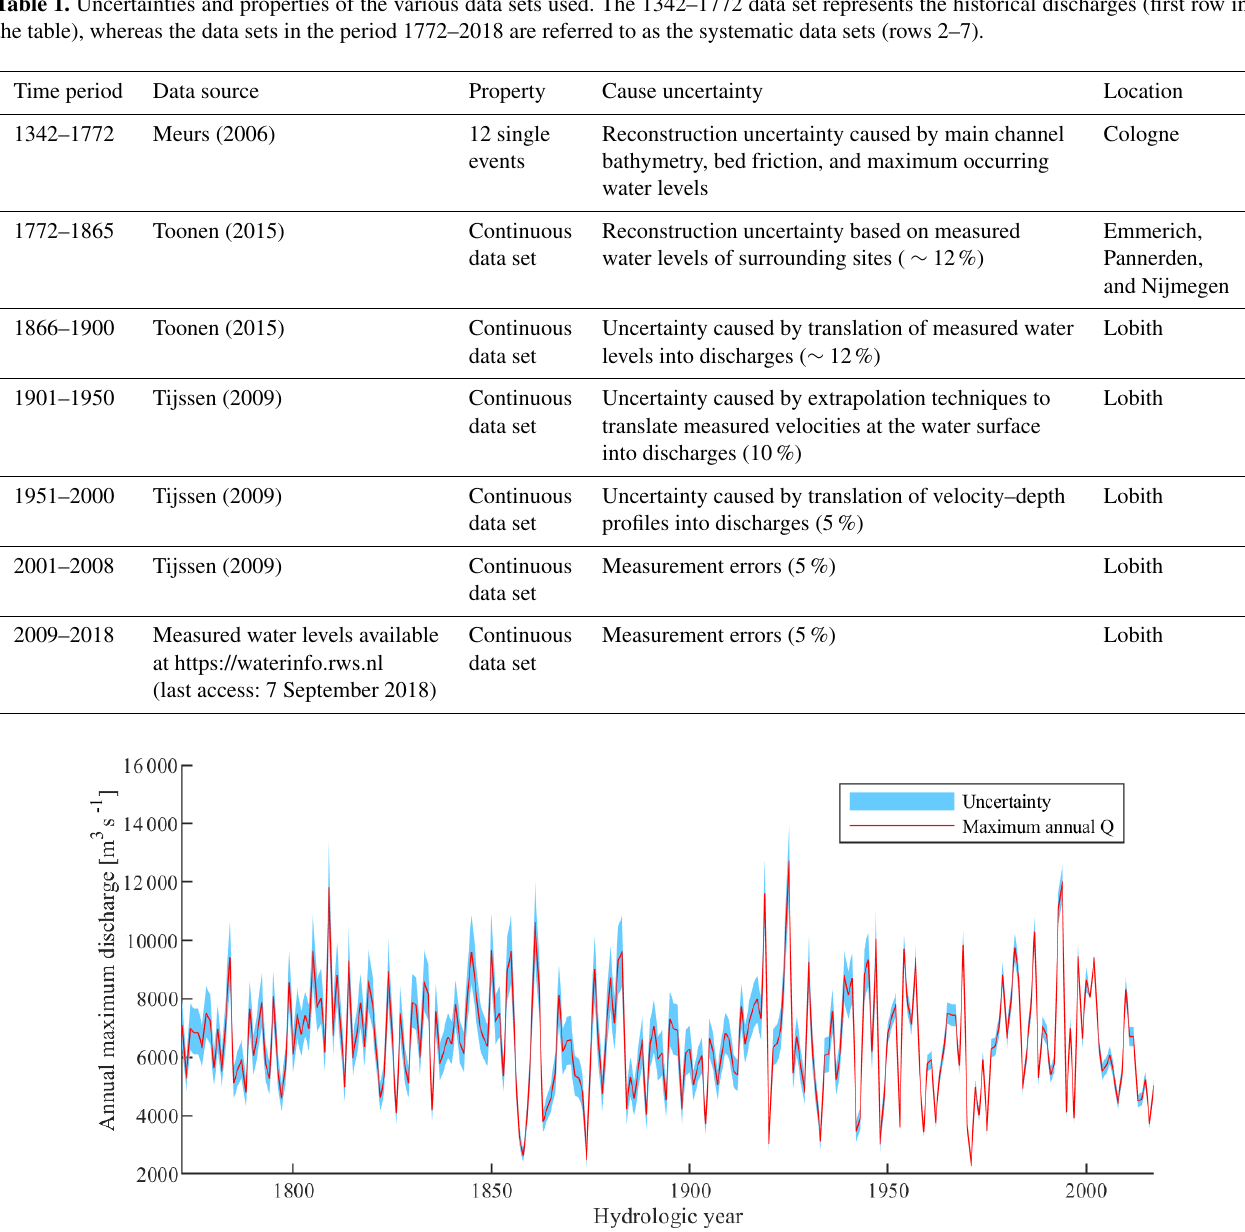
Table 1. Uncertainties and properties of the various data sets used. The 1342–1772 data set represents the historical discharges (first row in the table), whereas the data sets in the period 1772–2018 are referred to as the systematic data sets (rows 2–7).